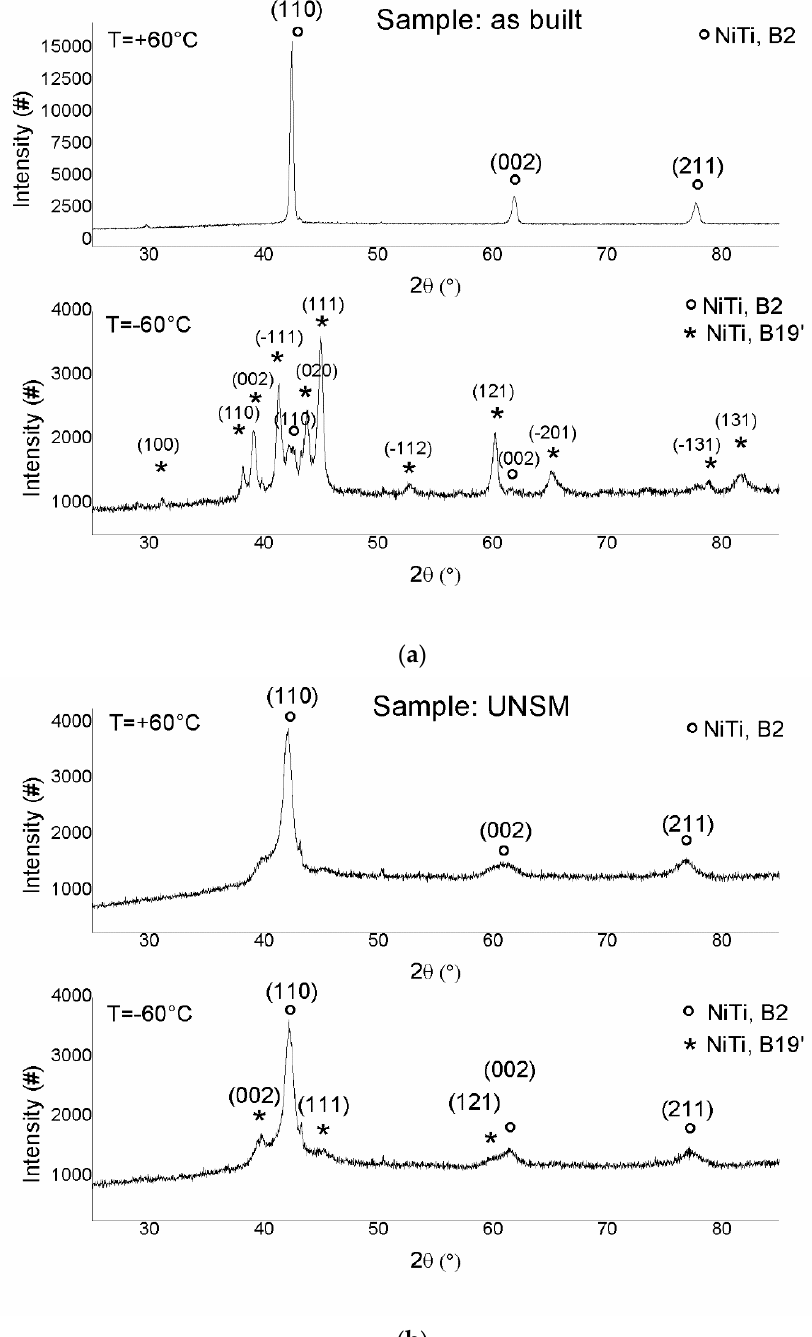
Figure 10. XRD pa tt erns at two temperatures ( − 60 °C and 60 °C) of as-built ( a ) and UNSMed ( b ) Figure 10. XRD patterns at two temperatures ( − 60 ◦ C and 60 ◦ C) of as-built ( a ) and UNSMed ( b ) surfaces.